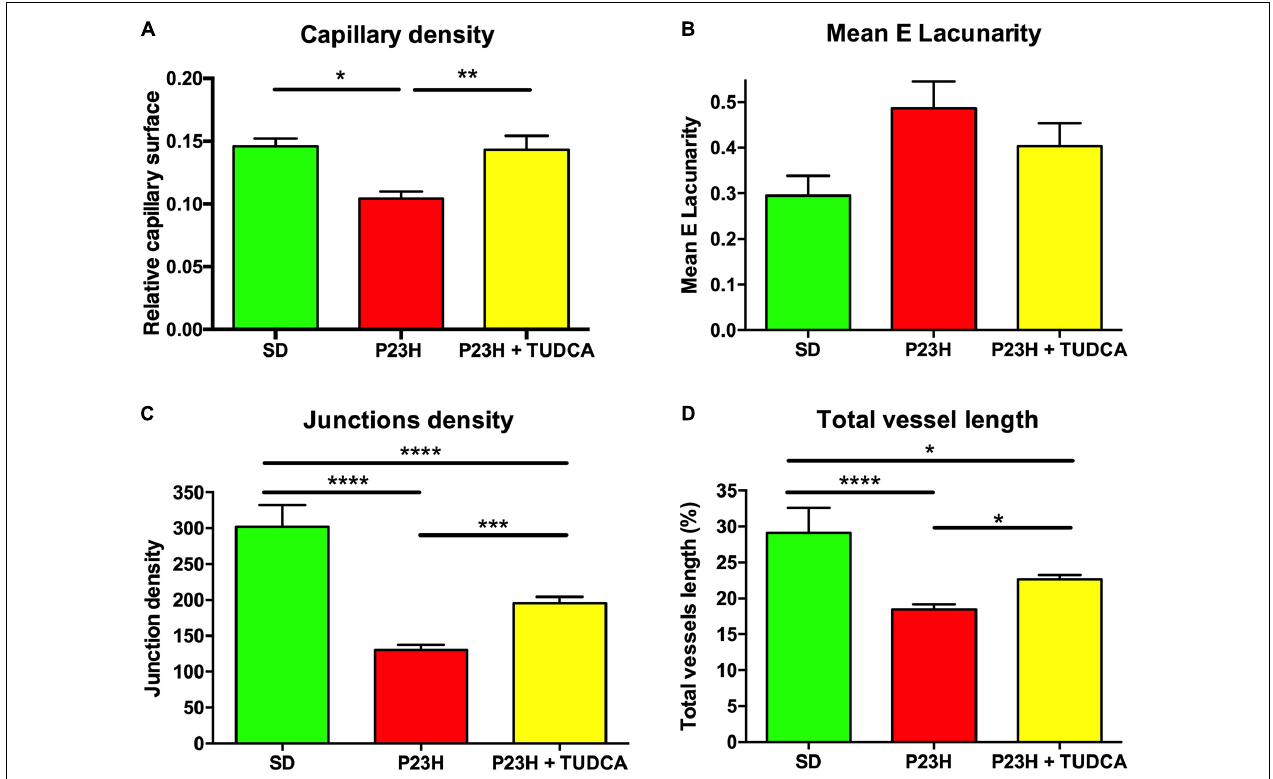
FIGURE 3 | Tauroursodeoxicholic acid (TUDCA) effects on deep capillary plexus density and complexity of P23H rats. (A) Mean relative capillary density (capillary area/retinal area), (B) mean E lacunarity values, (C) mean junction density, and (D) mean percentage of blood vessel length, for the DCP in SD, P23H, and TUDCA-treated P23H rats at P120. One-way ANOVA, Tukey’s multiple comparison test; * p < 0.05, ** p < 0.01, *** p < 0.001, **** p < 0.0001. SD: n = 3, P23H: n = 7, P23H + TUDCA: n =